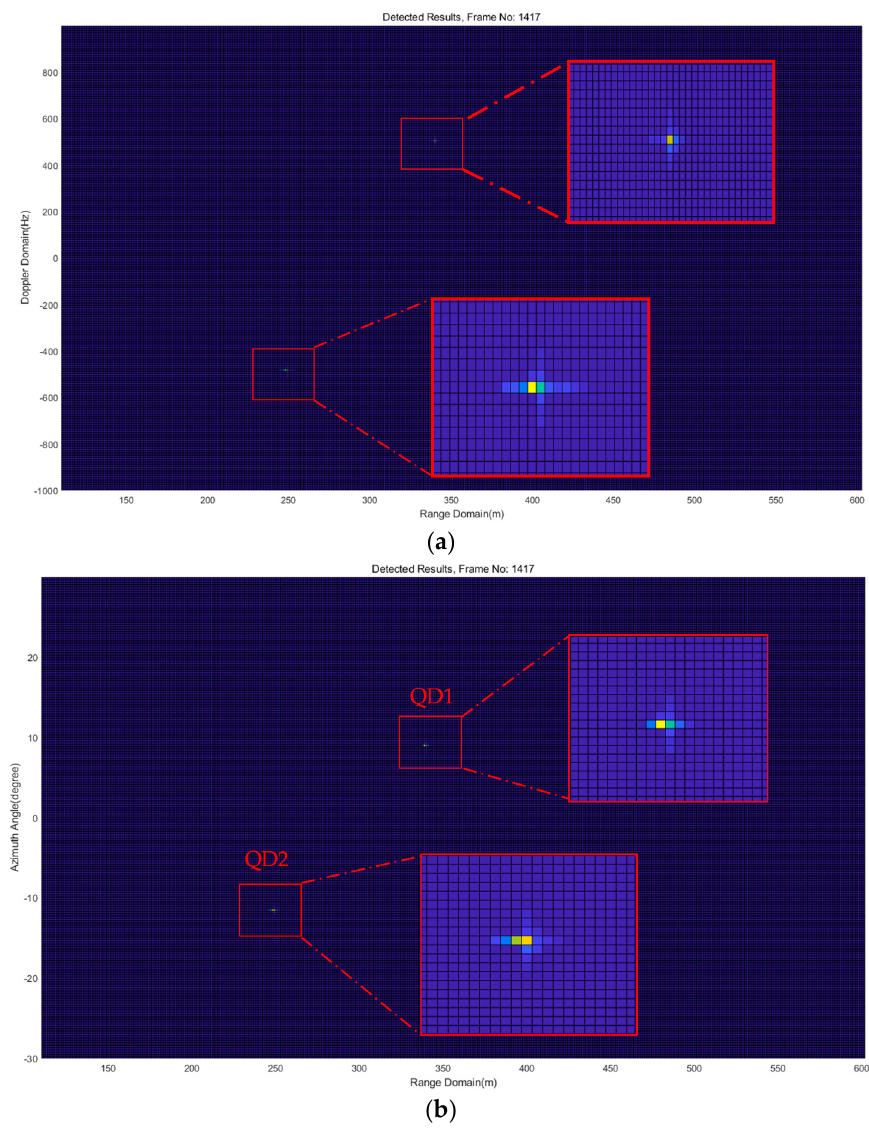
Figure 19. Illustration of one frame of detection results of Experiment 3, ( a ) range-Doppler map; ( b ) range-angle map.